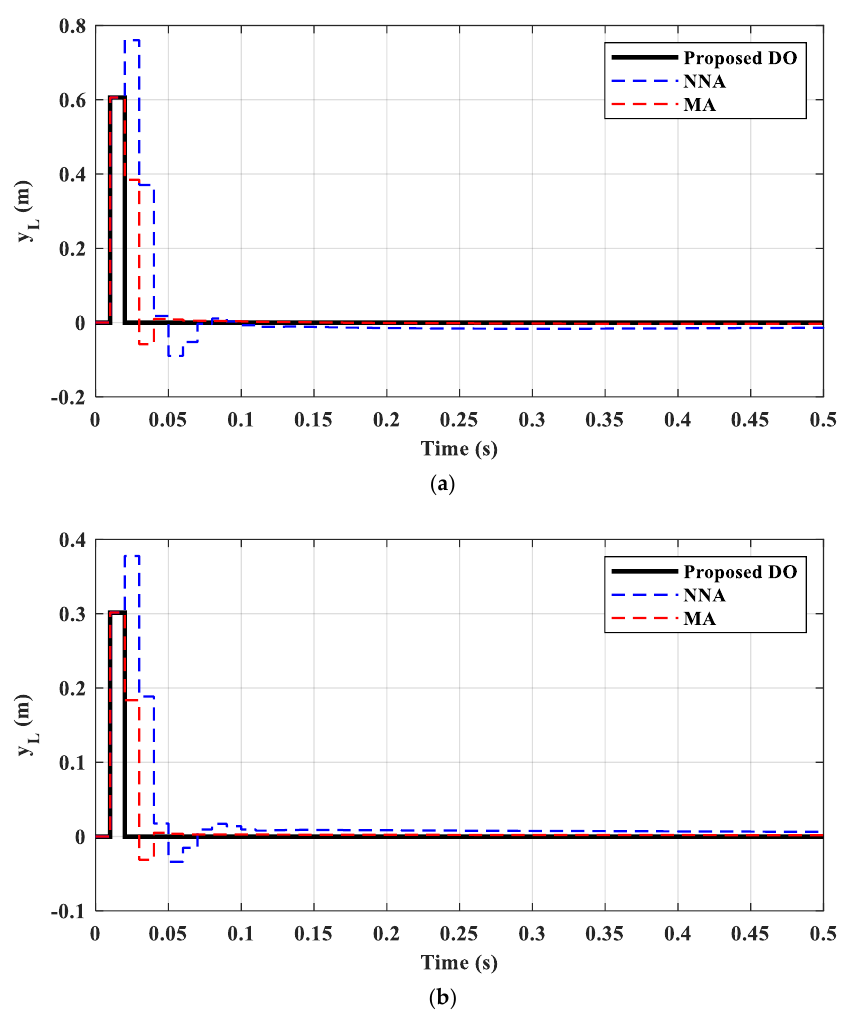
Figure 12. The output response of the AV lateral deviation against the velocity variations ( a ) +5 m/s increasing, ( b ) − 5 m/s decreasing.